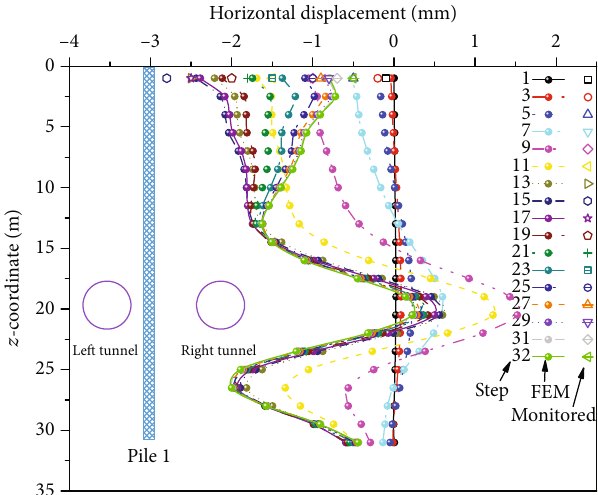
Figure 9: Horizontal displacements of Pile 1 at di ff erent tunneling